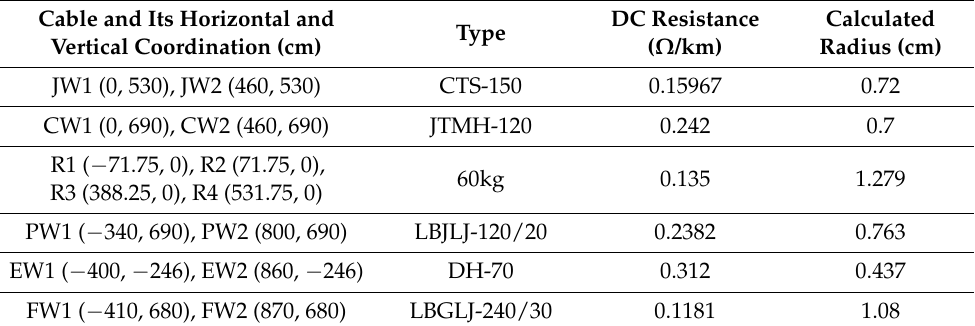
Table 2. Parameters of all the conductor wires in the HSR line from Chengdu to Chongqing. Cable and Its Horizontal